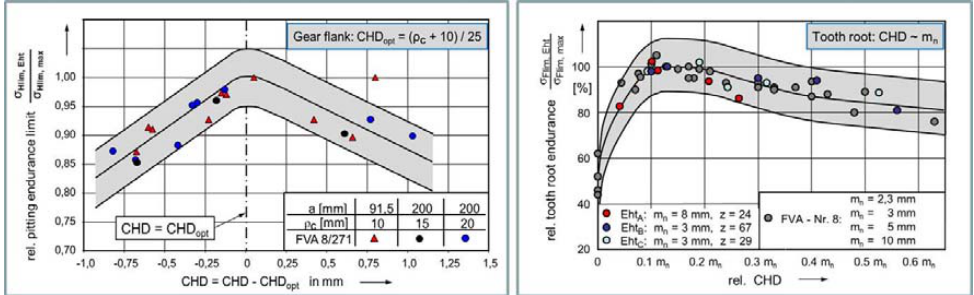
Figure 6. Influence of case hardening depth (Eht is identical to CHD) on the relative pitting endurance limit σ Hlim (left) and the relative tooth root endurance σ Flim (right) for different gear sizes [8]. Because a different hardness profile also influences the residual stresses (compressive residual stresses are assumed over the complete case carburized layer), not only the material strength, but also the equivalent stress curve are influenced by a different case hardening depth (Figure 7, left). Obviously, the ratio between local equivalent stress and local material strength is more critical for smaller CHD and, in this case, is most unfavorable at a depth that is close to the case ‐ core interface. Consequently, CHD is not only an important influencing parameter for the pitting and bending strength of gears, but may also strongly contribute to minimizing the risk of a crack initiation below the surface and thereby reducing the risk of failure due to tooth flank fracture (Figure 7, right). Furthermore, it is obvious that also increasing the core strength of the gear material may contribute to reducing the risk of a failure initiation at greater material depth.